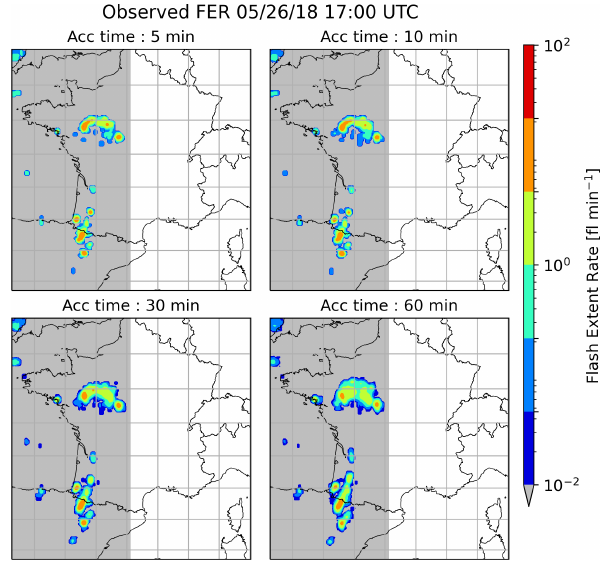
Figure 18. FER observed on 26 May 2018 at 17:00UTC for various accumulation